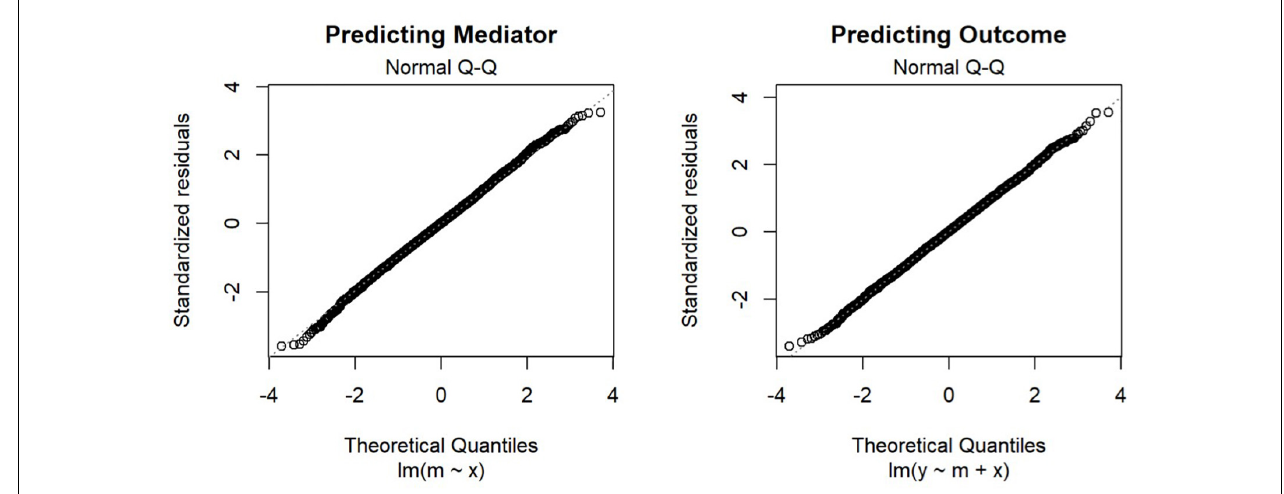
FIGURE 3 | Normal Q-Q Plot of